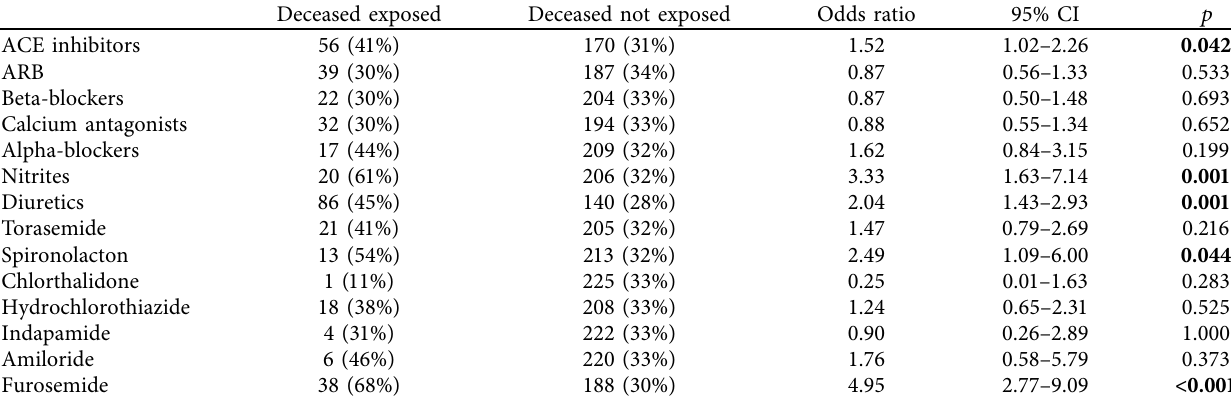
Table 3: Relationship between drug exposure and mortality at 5 years (univariate analysis).